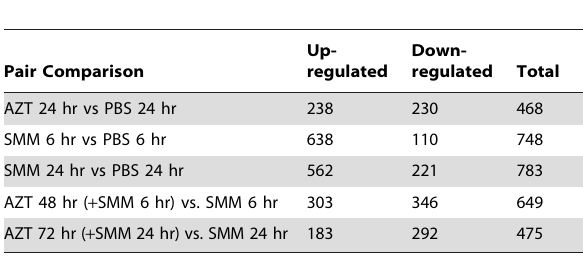
Table represents the number of significant probesets with LPE z.pv , 0.05. A list of all differentially-regulated probesets is found in Supporting Information, Table S2.